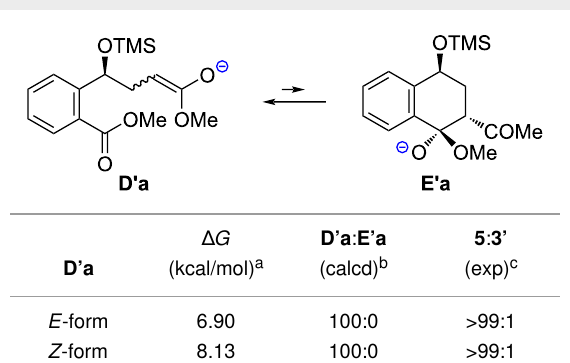
Table 5: Calculations of ∆ G from D’a to E’a